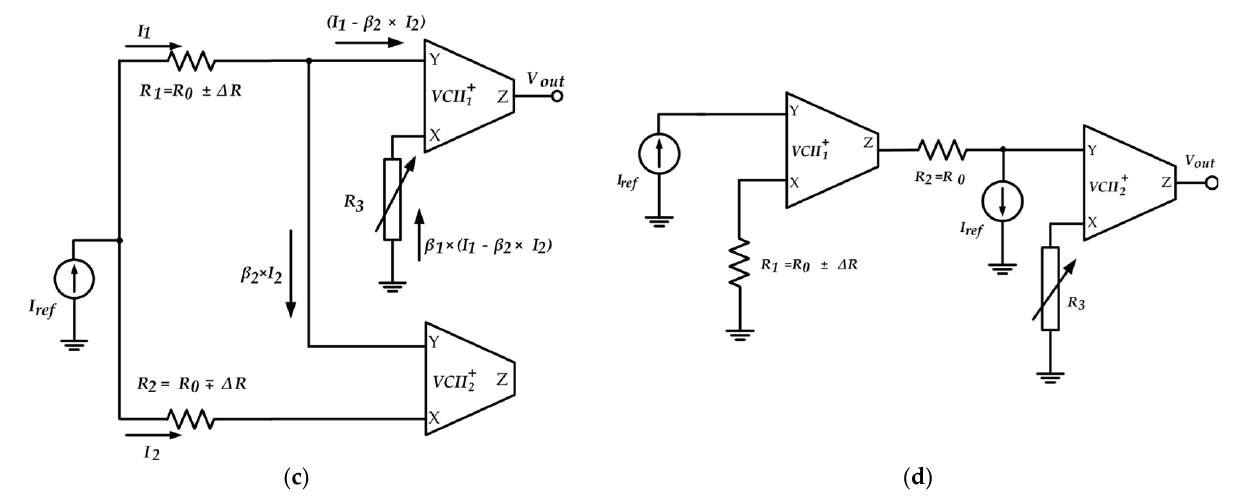
Figure 10. ( a ) The concept of a current-mode Wheatstone bridge; ( b ) CCII-based current-mode Wheatstone bridge; ( c ) VCII-based current-mode bridge for a couple of resistive sensors in differential operation; ( d ) VCII-based current-mode bridge for a single resistive sensor.